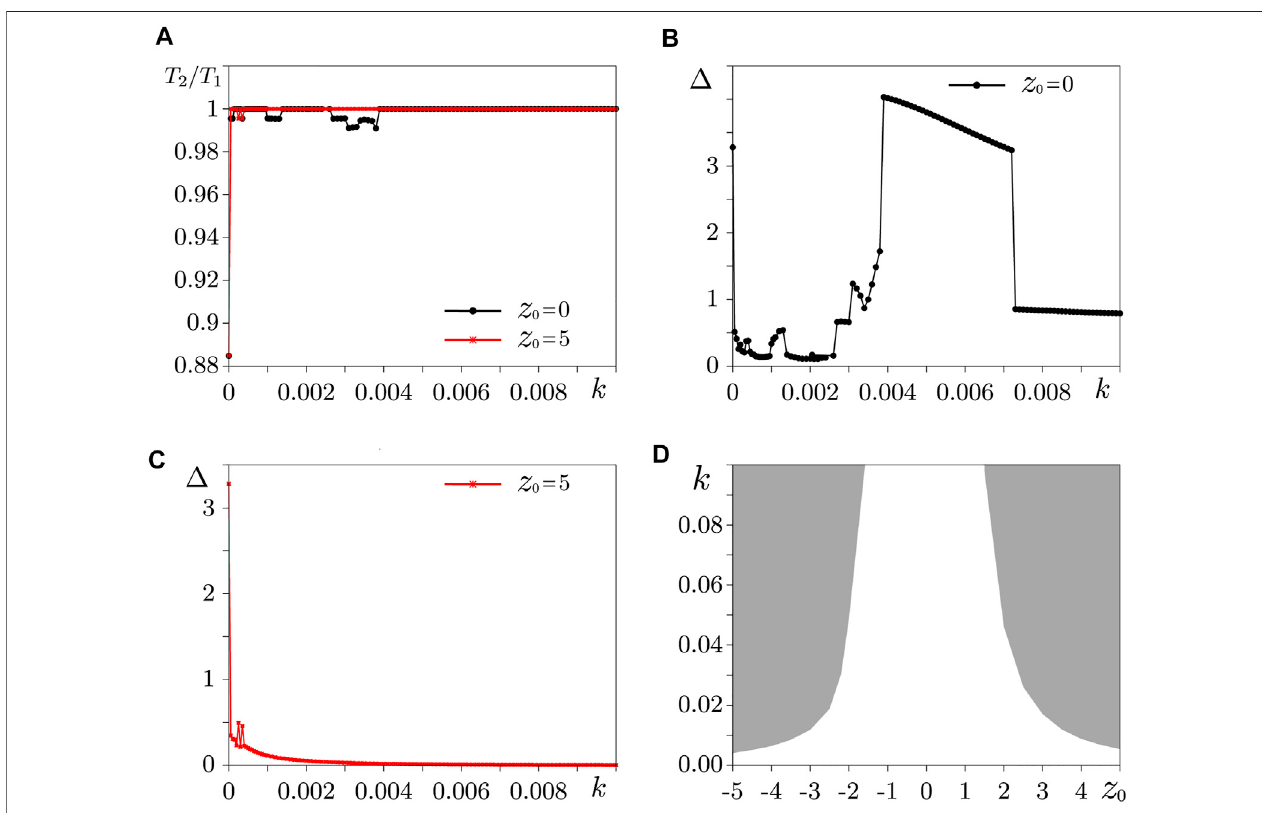
FIGURE5| Synchronizationcharacteristicsintwonon-identicalringsconnectedviaidealmemristors:dependenciesoftheratioofaverageoscillationperiods T 2 / T 1 at z 0 = 0 and z 0 = 5.0 (A) ; dependence of the synchronization error Δ on the coupling coef fi cient k at z 0 = 0 (B) and z 0 = 5.0 (C) ; region of effective synchronization of traveling waves determined by the condition Δ ≤ 10 – 2 (D) . Parameters: σ 1 = 4.5, σ 2 = 5.5, δ =